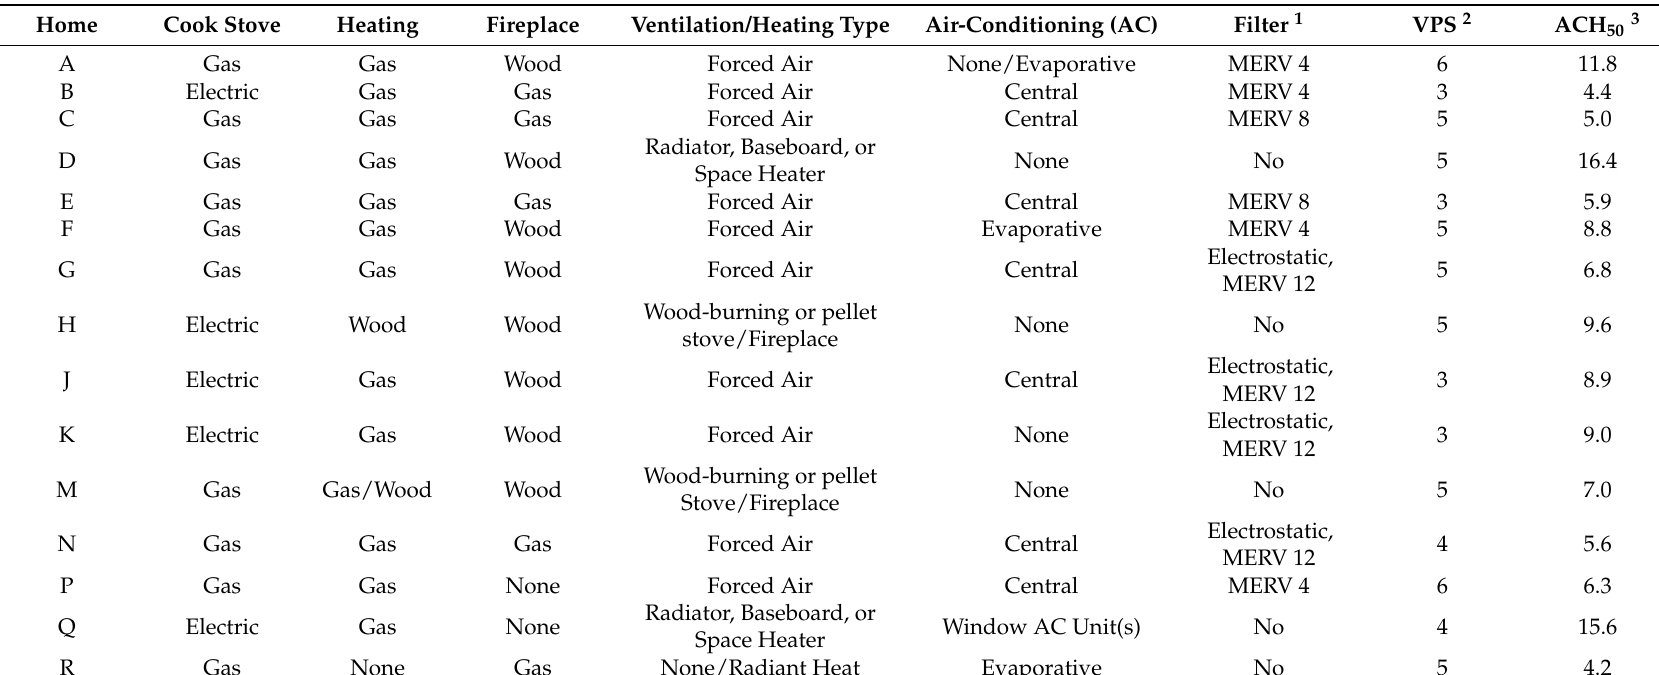
Table 2. Heating, ventilation and air-conditioning (HVAC) and potential pollutant source characteristics of study